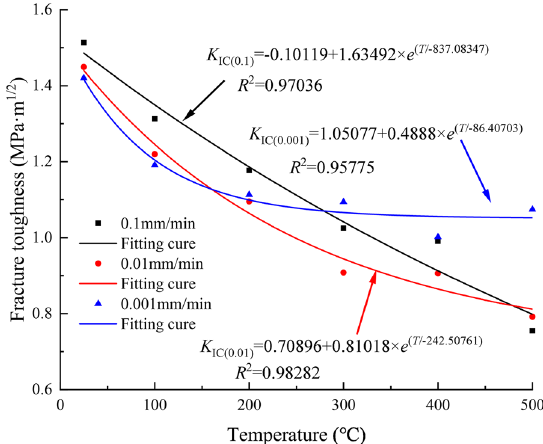
Fig. 6 Fracture toughness versus real‑time high